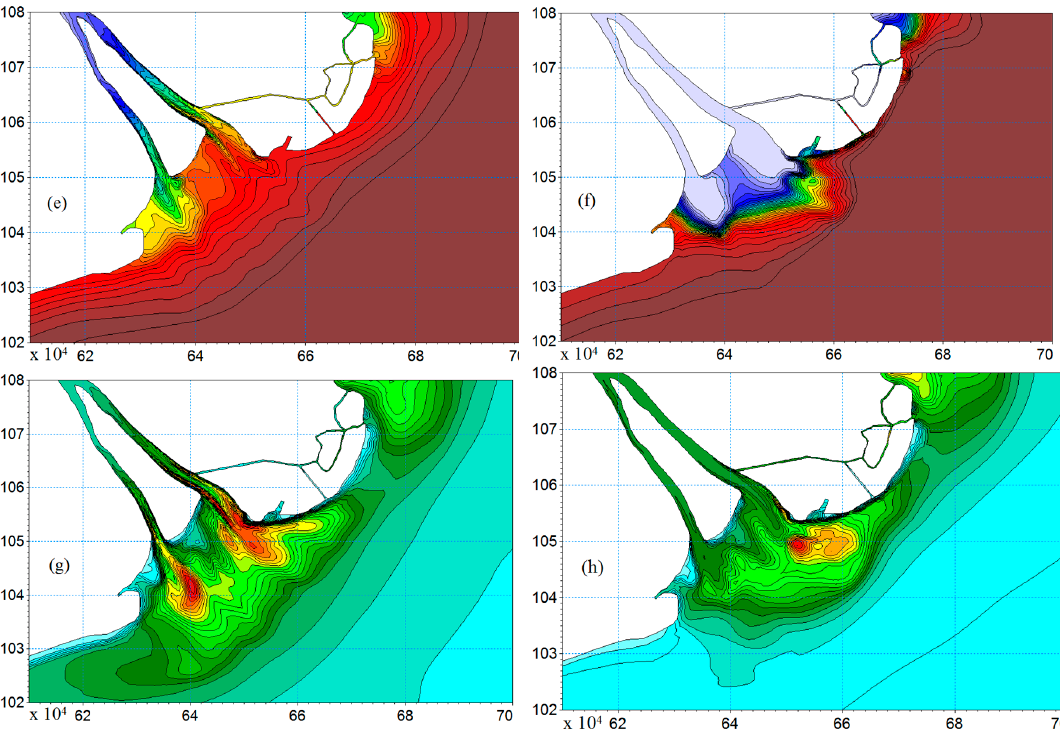
Figure 11. Spatial distribution of salinity (psu) and SSC (g L − 1 ) at low tide; ( a , b ) salinity in the dry and flood seasons in the surface layer; ( c , d ) SSC in the dry and flood seasons in the surface layer; ( e , f ) salinity in the dry and flood seasons in the bottom layer; ( g , h ) SSC in the dry and flood seasons in the bottom layer. Color scale is the same as in Figure 8.